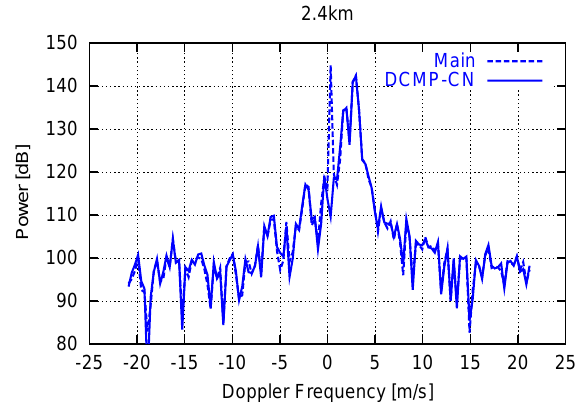
Fig. 5. Doppler echo power spectrum at 2.4km range raw main beam data (dashed) and processed with the proposed DCMP-CN algorithm